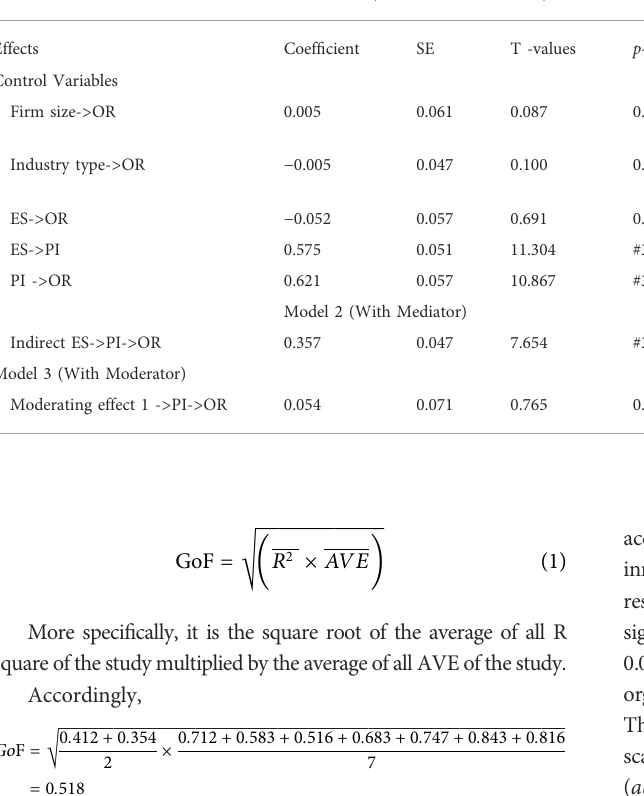
TABLE 6 Path coef fi cients for the different